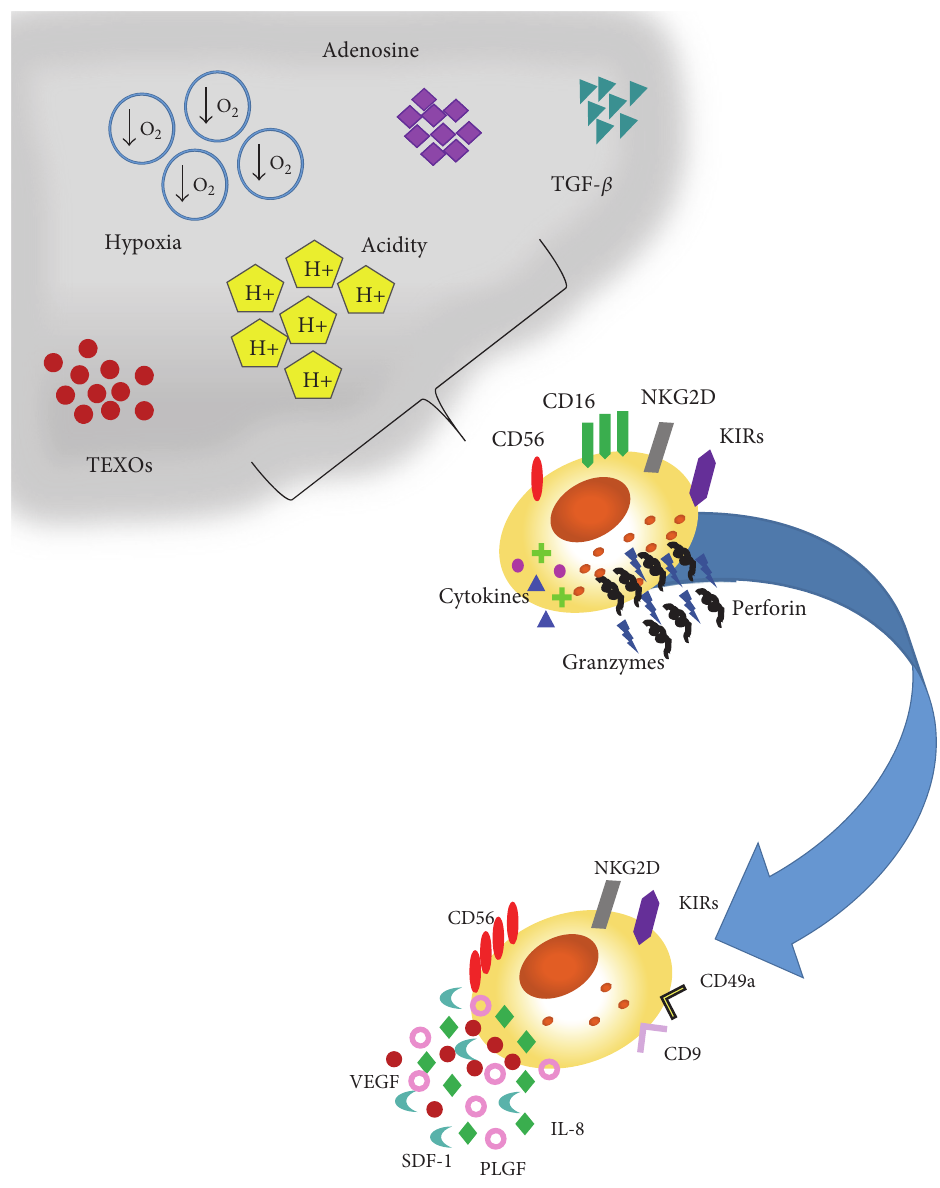
Figure 2: Soluble factors within the tumour microenvironment shaping NK cell functions. Several molecules and soluble factors within the tumour microenvironment, including TGF- 𝛽 , hypoxia, adenosine, acidic of the environment, and tumour exosomes (TEXOs), can inhibit NK response against tumours either by interfering with NK cell direct/cytokine mediated tumour cell lysis or by supporting tumour